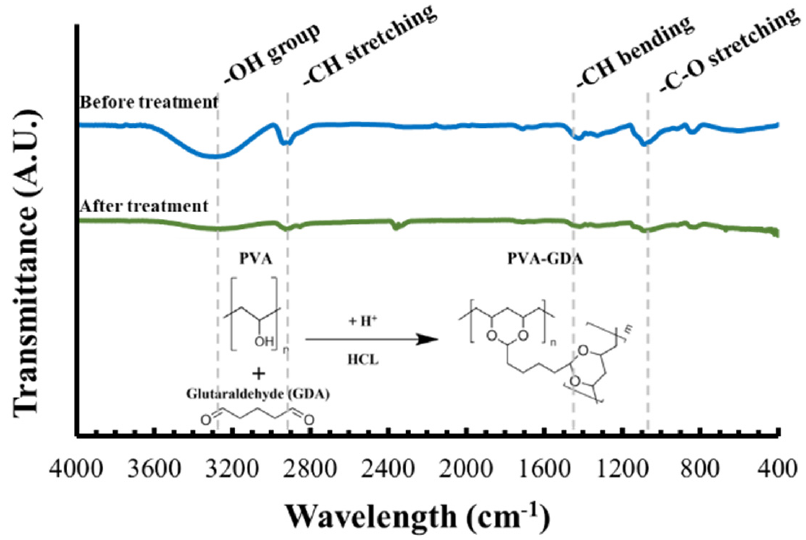
Figure 9. Chemical analysis and cross-linking confirmation.